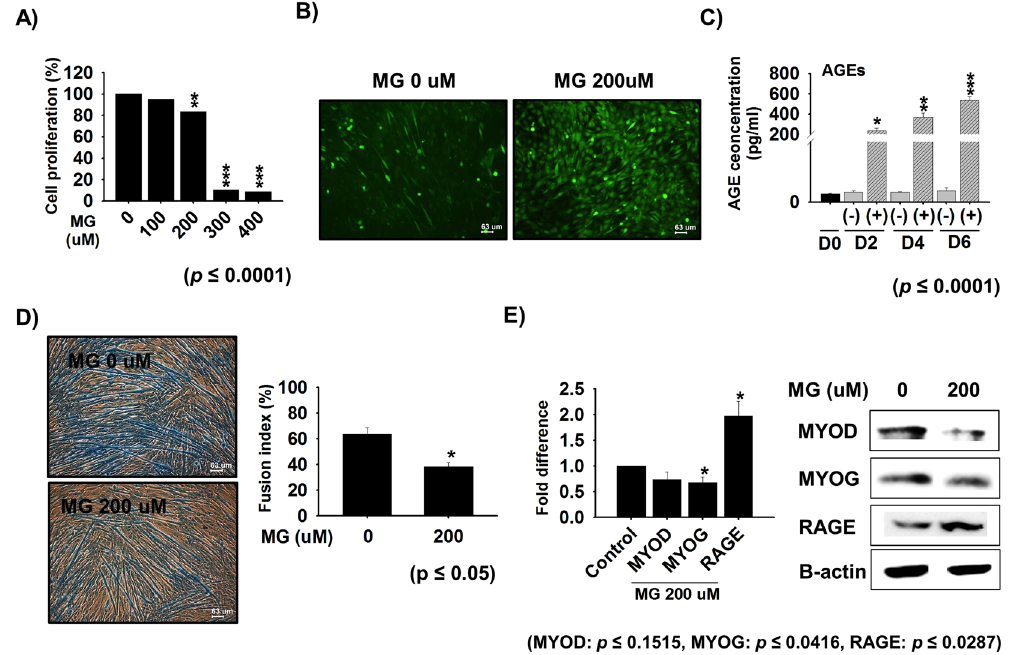
Figure 1. Association between MG induced AGE production and myogenesis. ( A ) Cell proliferation in the presence of different concentrations of MG at Day 4. ( B ) Cells were cultured with or without 200 µ M MG for 4 days in differentiation media and ROS levels were assessed using DCFDA by florescence microscopy (n = 3) ( C ) AGE levels after treatment with 200 µ M MG in differentiation media for 0, 2, 4, or 6 days [( − ): MG non-treated cells, ( + ): MG treated cells] ( D ) Myotube formation and fusion indices of cells treated with or without 200 µ M MG for 4 days in differentiation media ( E ) MYOD, MYOG and RAGE expressions determined by real time PCR and Western blot (n =